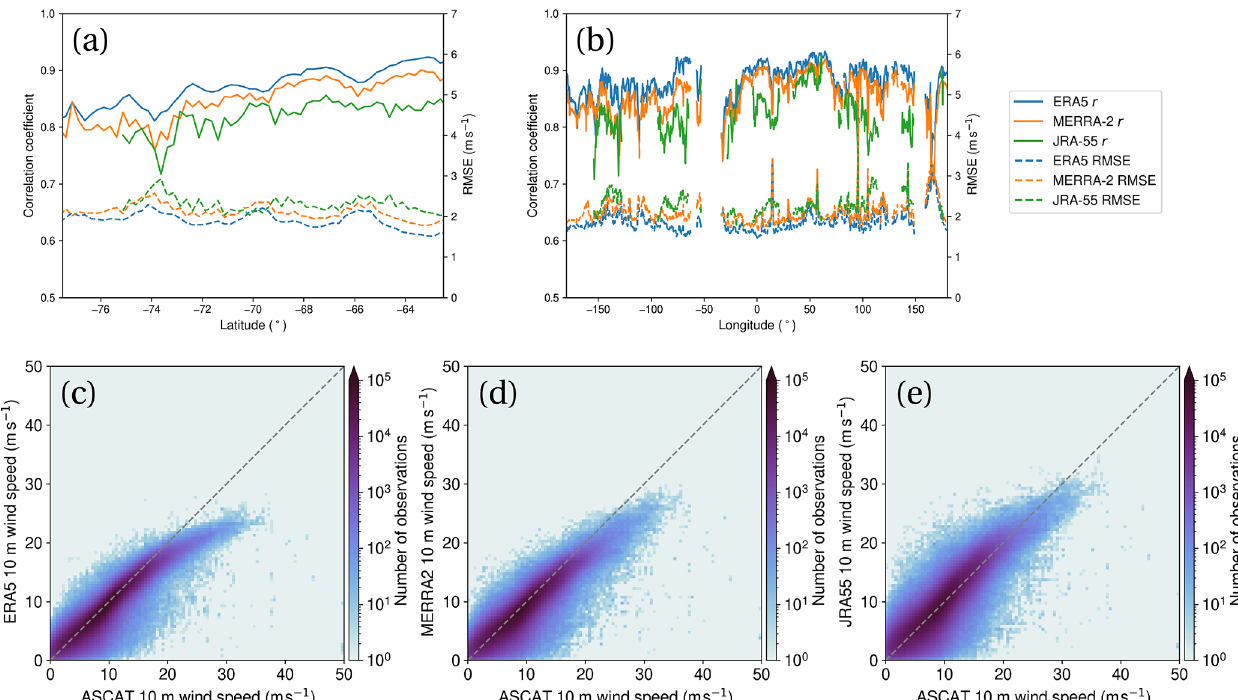
Figure 3. Mean wind speed performance metrics by (a) latitude and (b) longitude against ASCAT for ERA5 (blue), MERRA-2 (orange) and JRA-55 (green). Includes correlation coefficient (solid) and RMSE (dashed). (c–e) Heat map scatterplots of collocated data points within the coastal easterly domain for (c) ERA5, (d) MERRA-2 and (e) JRA-55. Only data points collocated in all three reanalyses are included in panels (c) – (e) . Data points which are rain flagged or have a GMF-matchup flag value over 2 are not included.